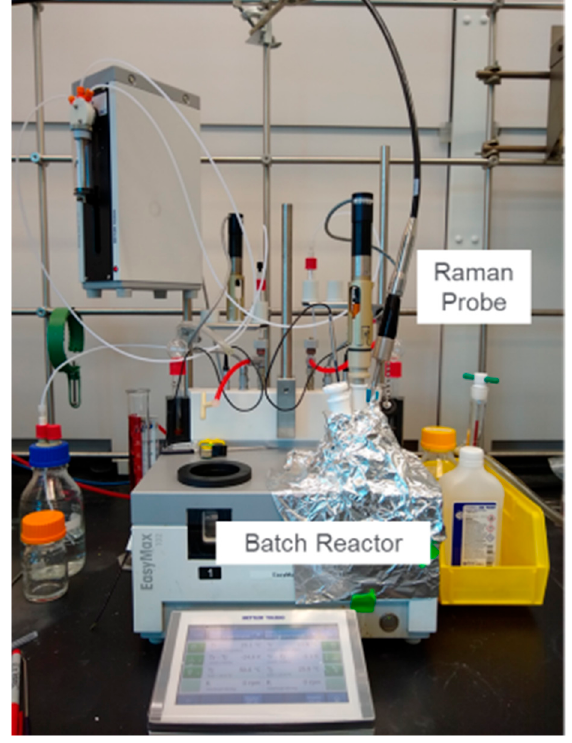
Figure 1. Experimental Setup. Table 1. The set of four disproportionation runs for each salt and their corresponding starting solid concentration.